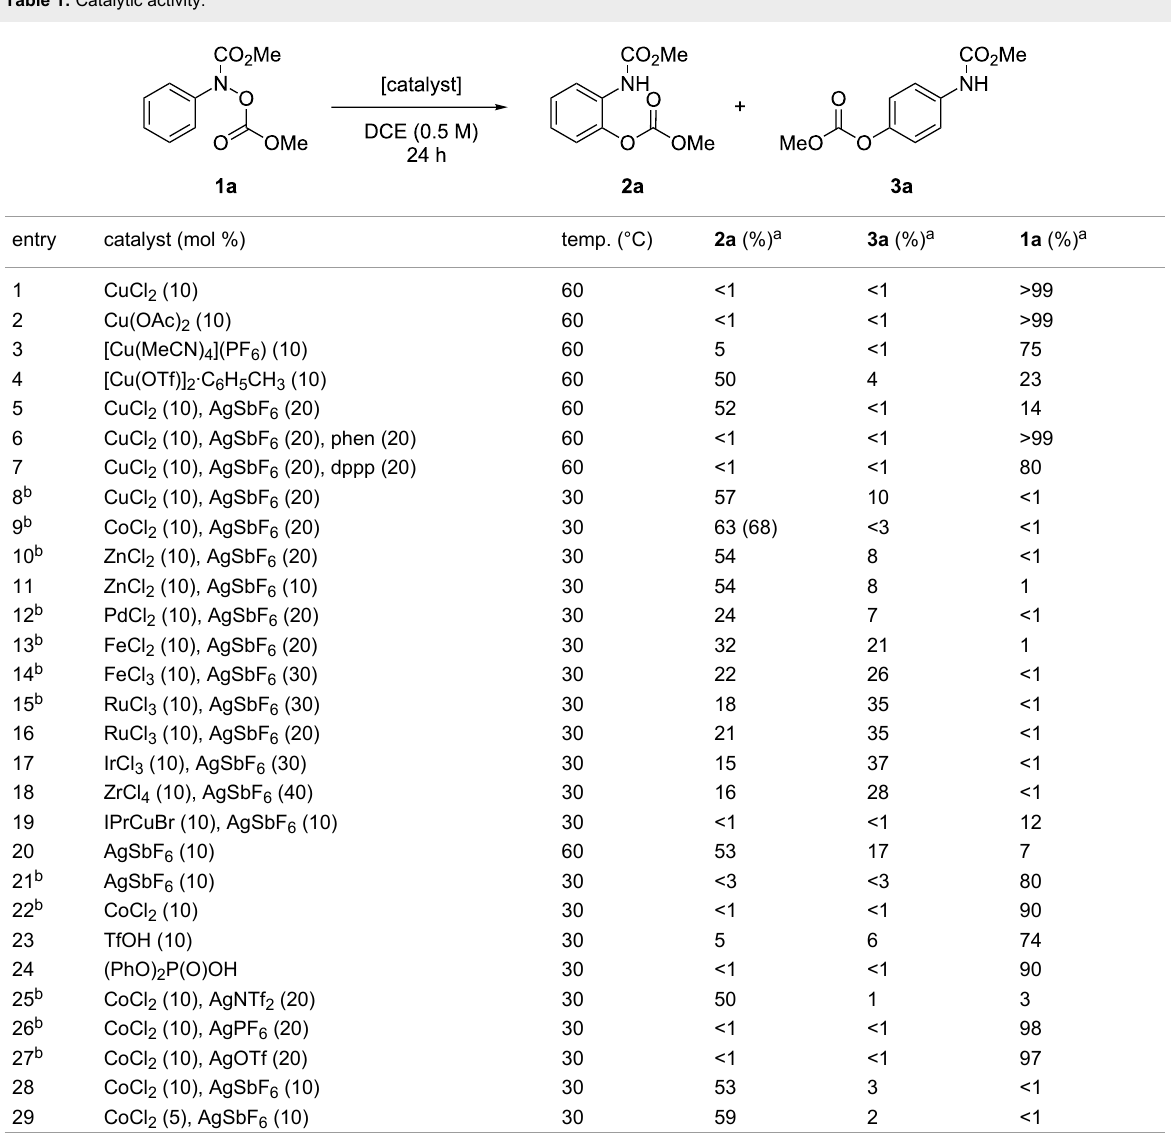
Table 1: Catalytic